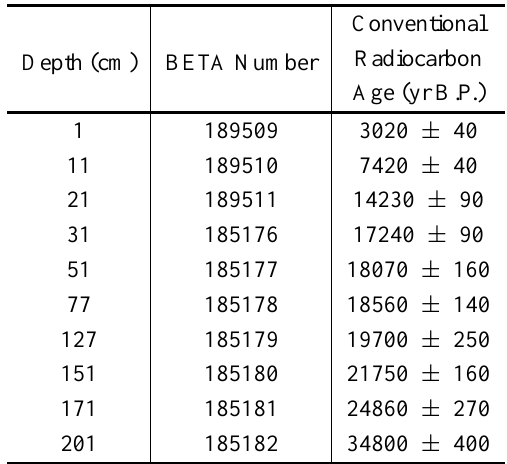
Radiocarbon ages of core